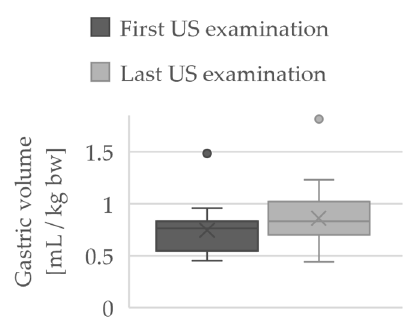
Figure 2. Boxplots of the GRV in mL/kg bw at first and last US examination.